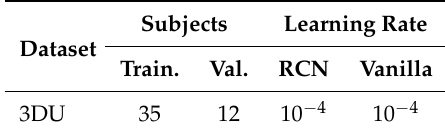
Table 1. Parameters for training 3DU dataset.